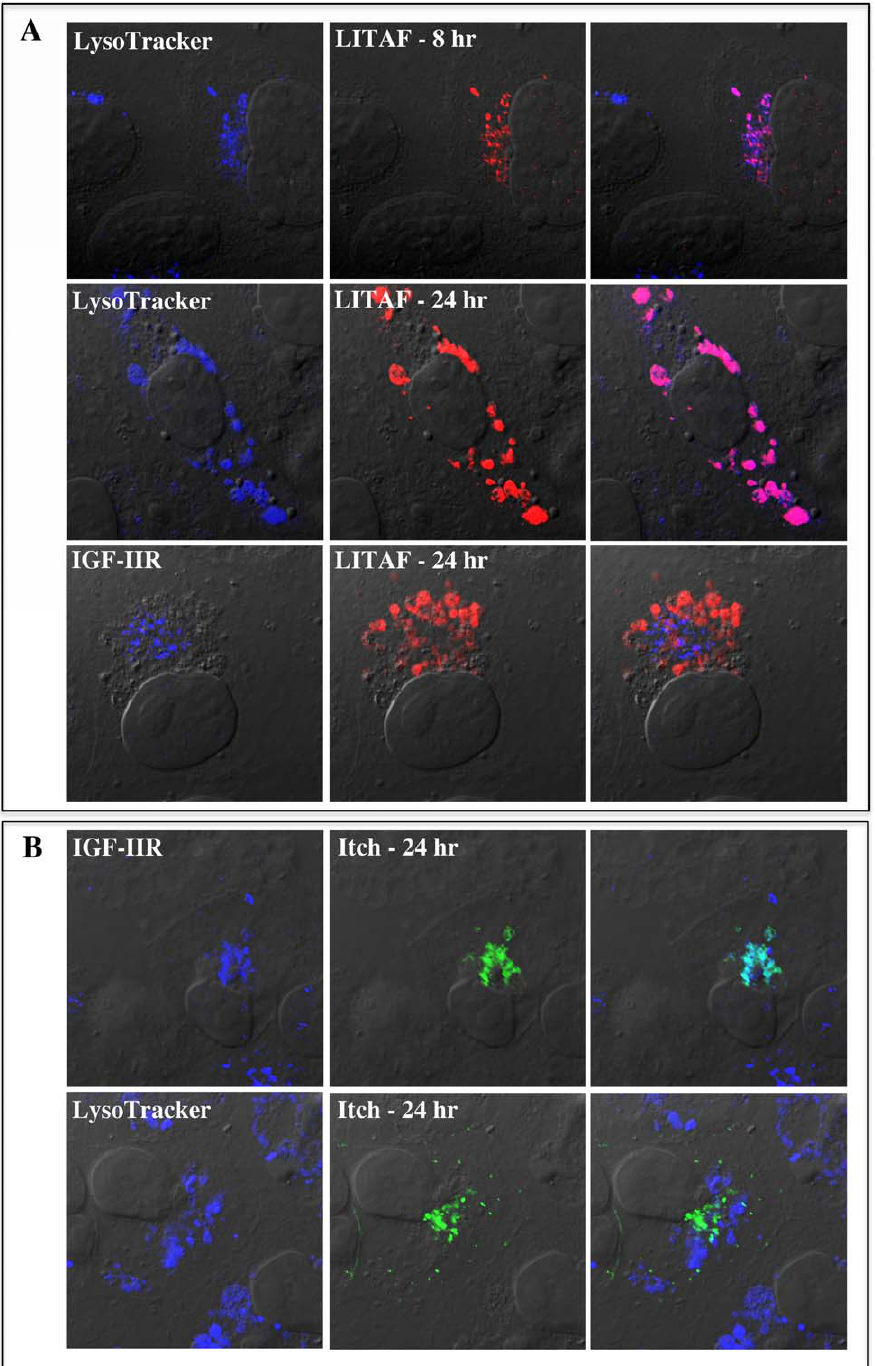
Figure 2. LITAF and Itch cellular localization. BGMK cells were transiently transfected for 8 or 24 hours with (A) FLAG-LITAF or (B) GFP-Itch. Live cells were initially incubated with LysoTracker followed by fixation and permeabilization. Cells then underwent indirect immunofluorescence using anti-IGF-IIR (trans Golgi-network; blue) and/or anti-FLAG antibodies (LITAF; red). GFP-Itch is shown in green. Differential interference contrast (DIC) was used to visualize cells and images were captured using a laser scanning confocal microscope.